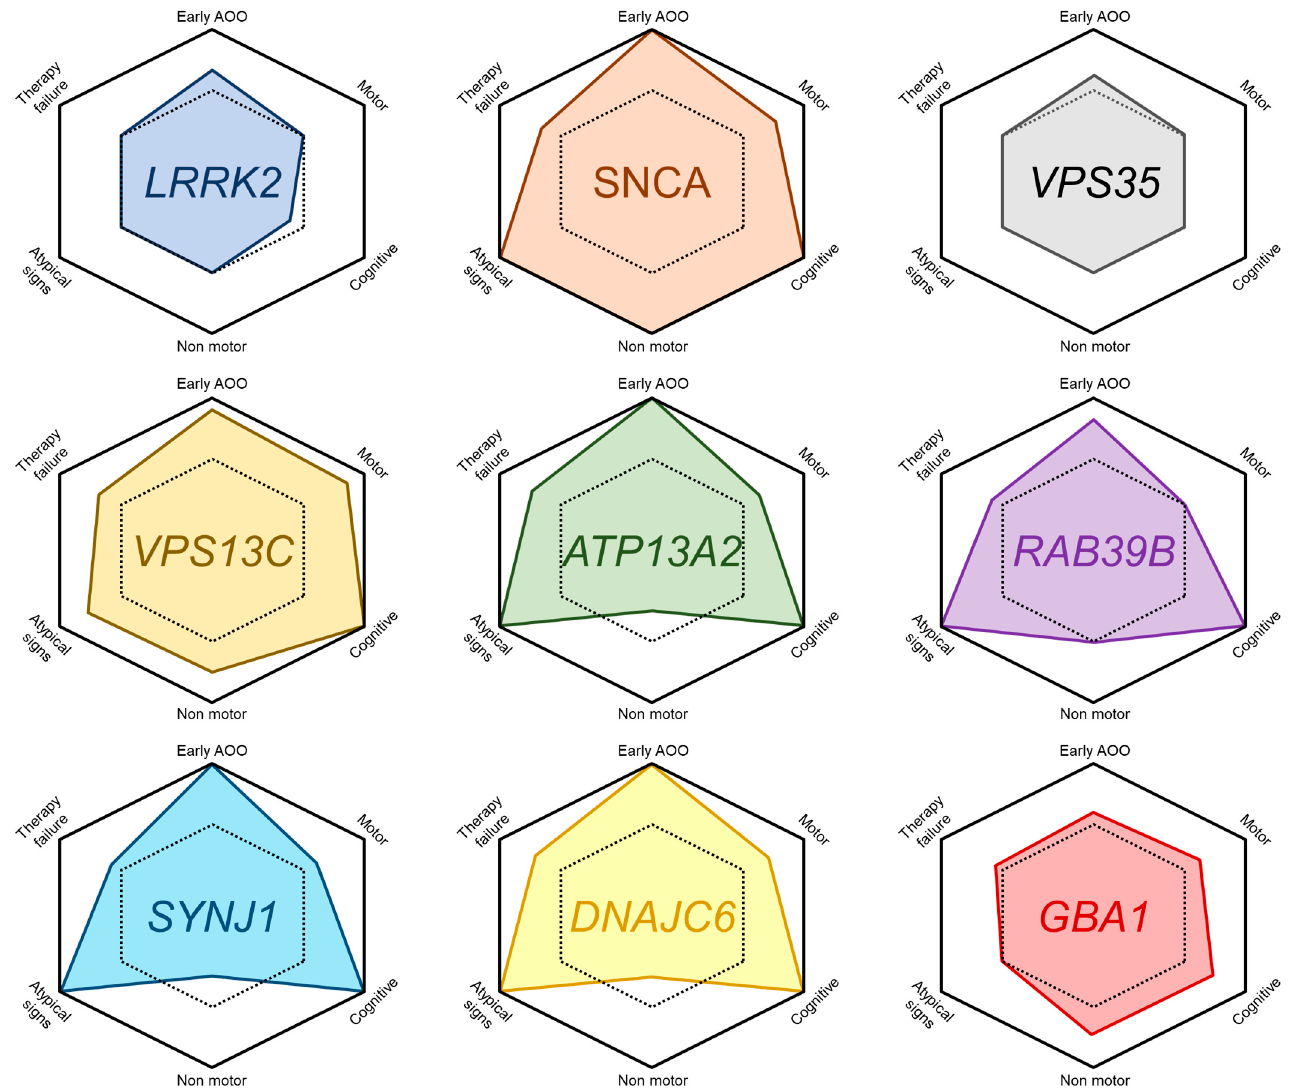
Figure 2. Phenotypic comparison between each monogenic form and idiopathic PD (represented by the dashed hexagon). The considered features are: age of onset (AOO), motor signs (bradykinesia, rigidity, rest tremor), cognitive problems (including neuropsychiatric symptoms and intellectual disability in the case of RAB39B ), non-motor symptoms of PD including (dysautonomia, hyposmia, REM sleep behavior disorder), atypical signs (e.g., epilepsy, spasticity, dystonia, dysmorphisms), and therapy failure (poor response to levodopa treatment or early onset of LID and